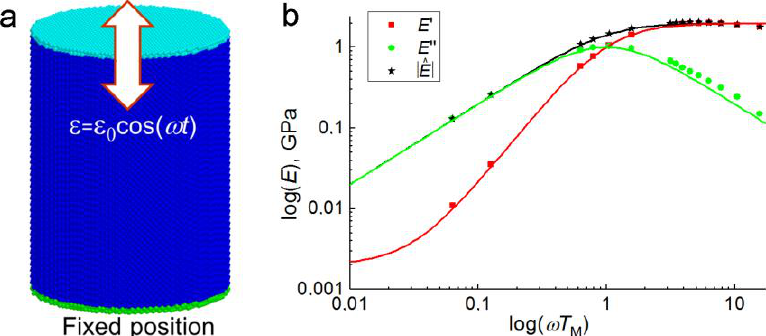
Fig. 2. The model sample of viscoelastic material and the loading scheme (a), and the numerically derived dependences of real, imaginary and total Young’s moduli on the frequency of cyclic loading (b). The sample is modeled by an ensemble of close-packed automata of the same size (face-centered cubic packing). The parameters of the standard model correspond to typical values for rubber: G K =0.8 MPa, G = G K + G M =800 GPa, Poisson ratio  =0.4,  М =1 MPa  s. The amplitude of applied strain:  0 =0.1. Points in (b) are numerically obtained values; solid lines are analytical solutions